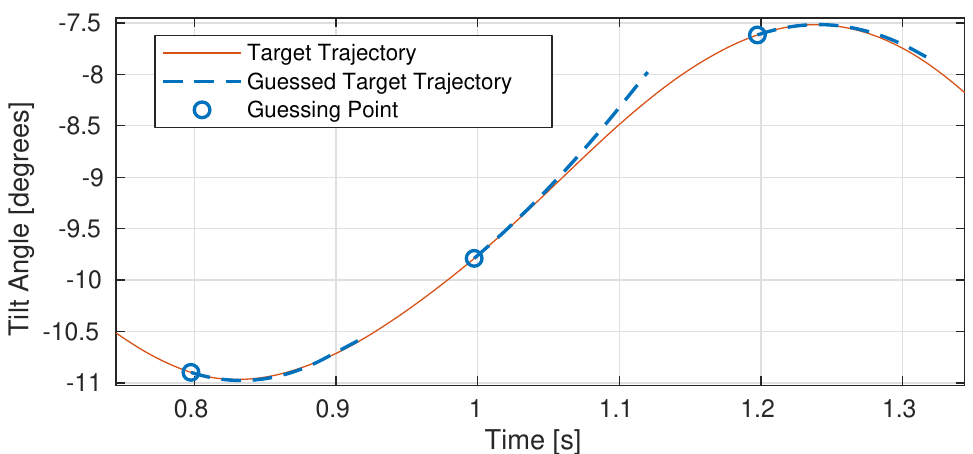
Figure 3. An example of results of the Trajectory Guessing